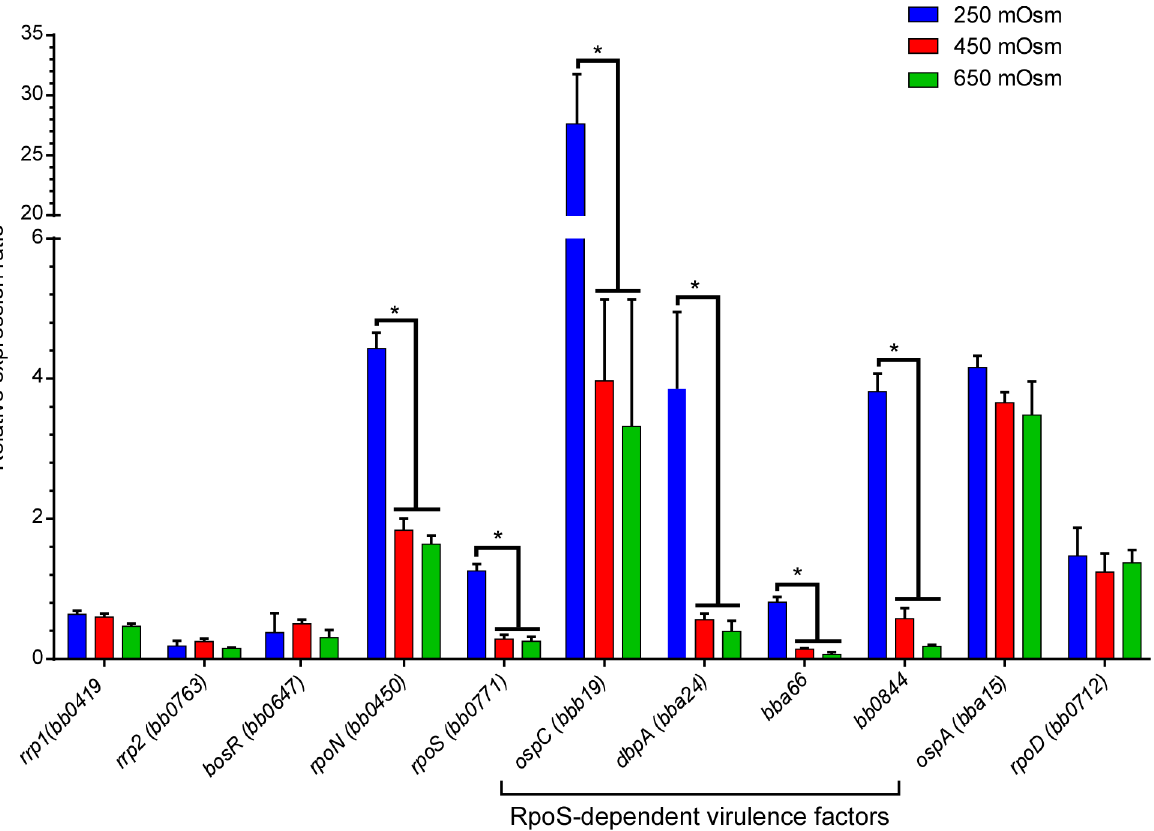
Fig 4. Gene expression of genes encoding crucial regulatory proteins and virulence factors at 250, 450 and 650 mOsm. The expression of genes encoding regulatory proteins ( rrp1 , bosR , rrp2 , rpoS , rpoN ), virulence factors ( ospC , dbpA , bba66 , bb0844 , ospA ) and rpoD analyzed by qRT-PCR in B . burgdorferi B31-A3. RNA isolated from cells grown at 250, 450 and 650 mOsm. The gene expression was normalized to enoS